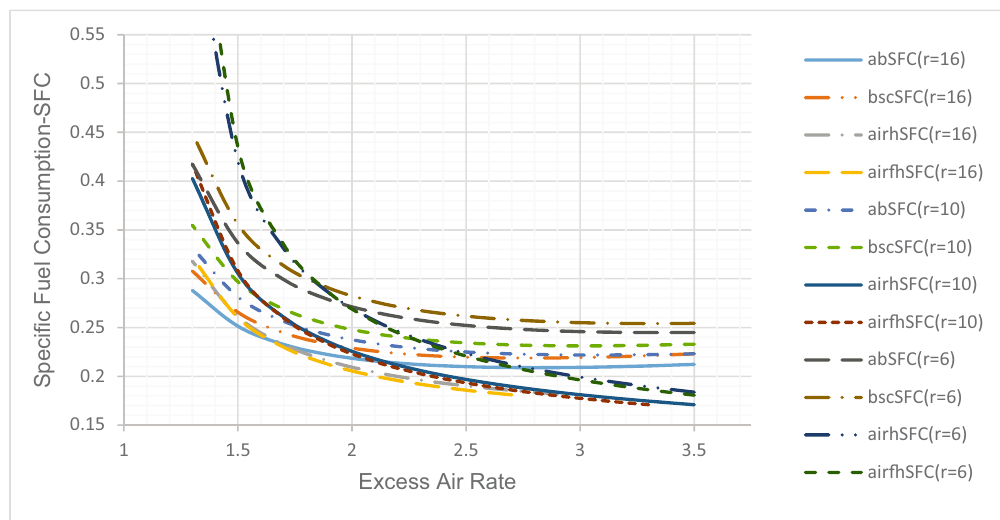
Figure 15: Variation of speci fi c fuel consumption with excess air coe ffi cient at di ff erent compressor compression rates for basic ( bsc ) , absorption cooling ( ab ) , air ( airh ) , and air fuel ( airfh ) heating cogeneration cycles ( m fuel = 1.64 kg/h, η isC = η isT = 0.86, r = 10, T recout = 850 K, T = 485.57 K, and T = 426 K ) steam Exh